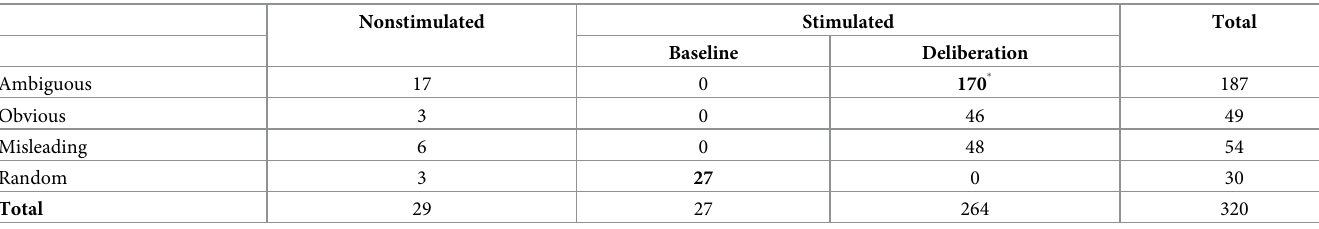
Table 1. Number of trials for each trial type and TMS timing.